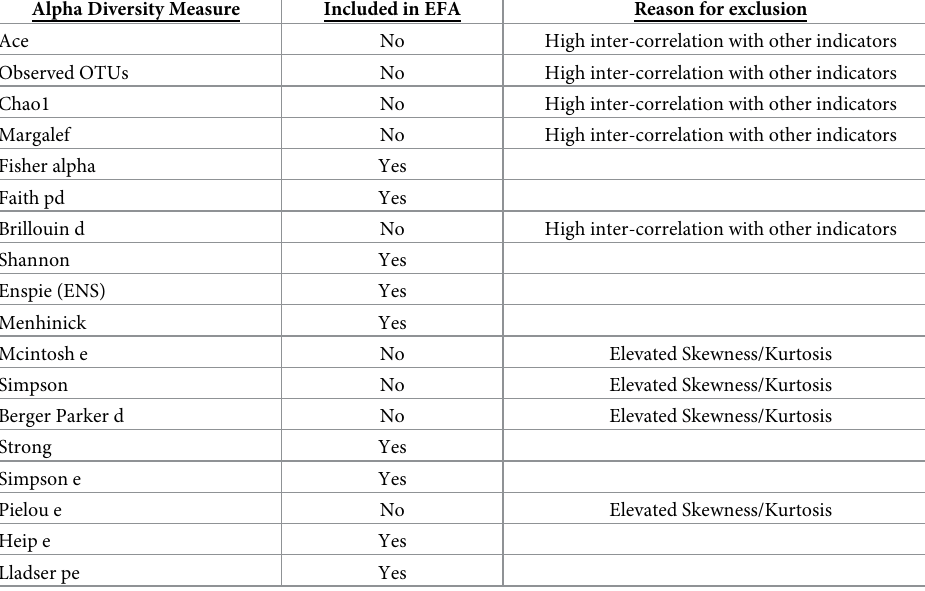
Table 3. Summary of alpha diversity metrics.